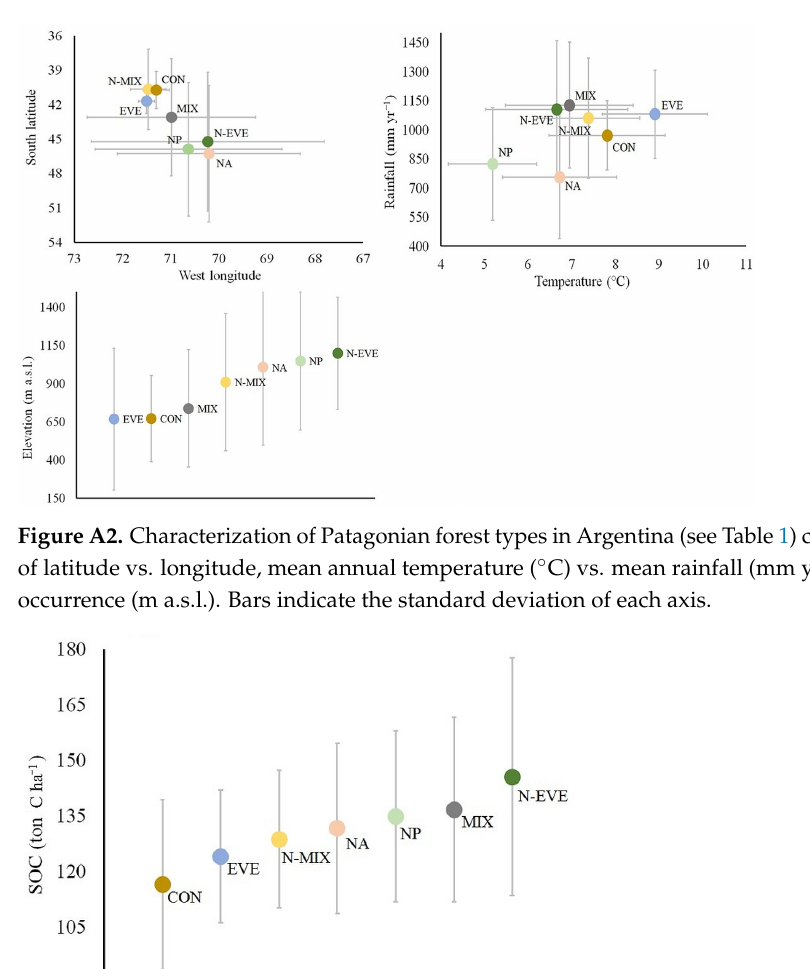
Figure A1. Soil organic carbon content (SOC) of different Patagonian forest types in Argentina (see Table 1), classified by mean annual temperature (°C), mean rainfall (mm yr − 1 ) and elevation (m a.s.l.). Bars indicate the standard deviation of each axis.